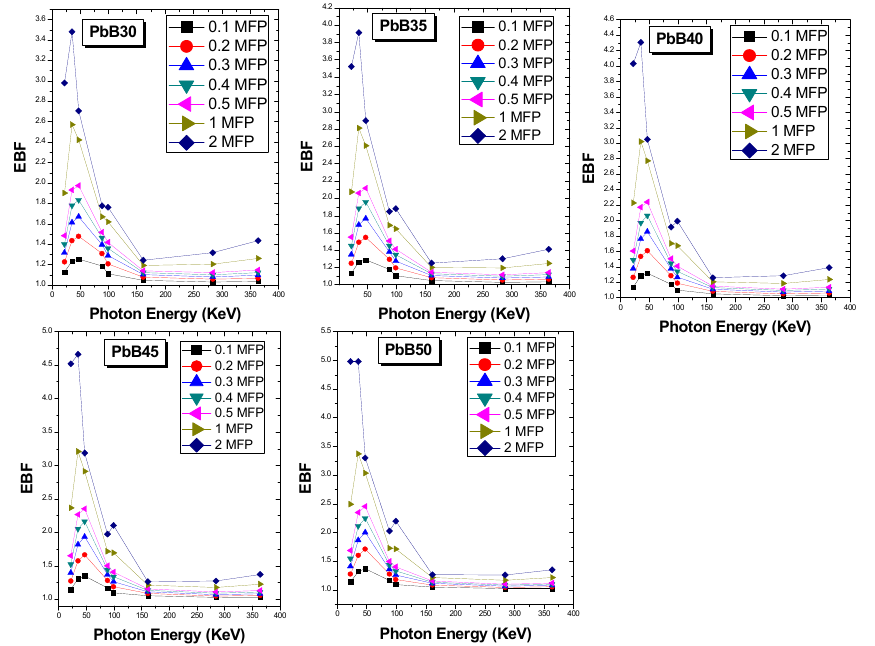
Figure 6. Variation of EBF with energy at selected depth up to 2 MFP. In order to compare the shielding power of the investigated glass system with those of conventional shields (ordinary concrete (OC), high density steel magnetite concrete (StMag) and two commercial glass shields containing lead known with the tradenames RS-360 and RS-253-G18), the mean free path (MFP) was used. As a shielding parameter, high MFP indicates that photon moves a large distance before interaction, and hence attenuation is reduced. Figures 8 and 9 show the comparison in the value of MFP of the glass systems and those of other materials (OC, StMag), RS-360 and RS-253-G18) at all the considered photon energies. The figures reveal that MFP increases with energy for all media due to low interaction cross section of photons at higher energies. However, at equal energy, the photon shielding capacity of the PbB-glasses was superior to those of the compared materials. This is a strong empirical indication that the glasses included in the present study possess better photon protection capacity compared to these conventional